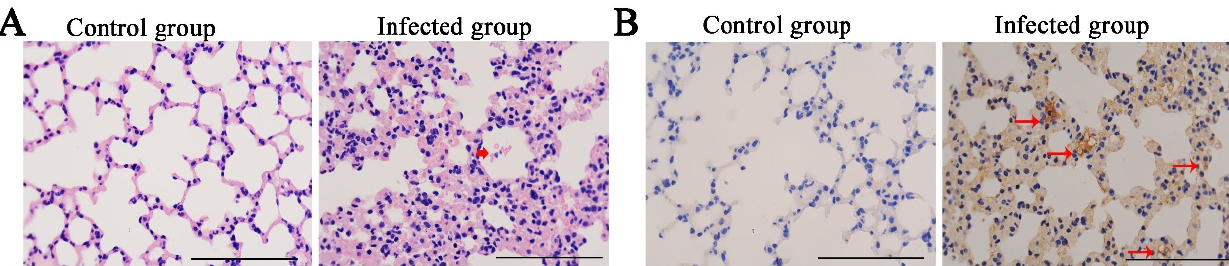
Figure 3. Histopathology and Immunohistochemistry Evaluation . The lungs from both group 1 and group 2 mice were fixed at 6 dpi to perform a histopathological examination by H.E ( A ) and immunohistochemistry (IHC) for EHV-8 antigen detection using EHV-8-positive serum ( B ). Bar: 100 µm. Broad arrow indicated hemorrhage; narrow arrow indicated EHV-8.